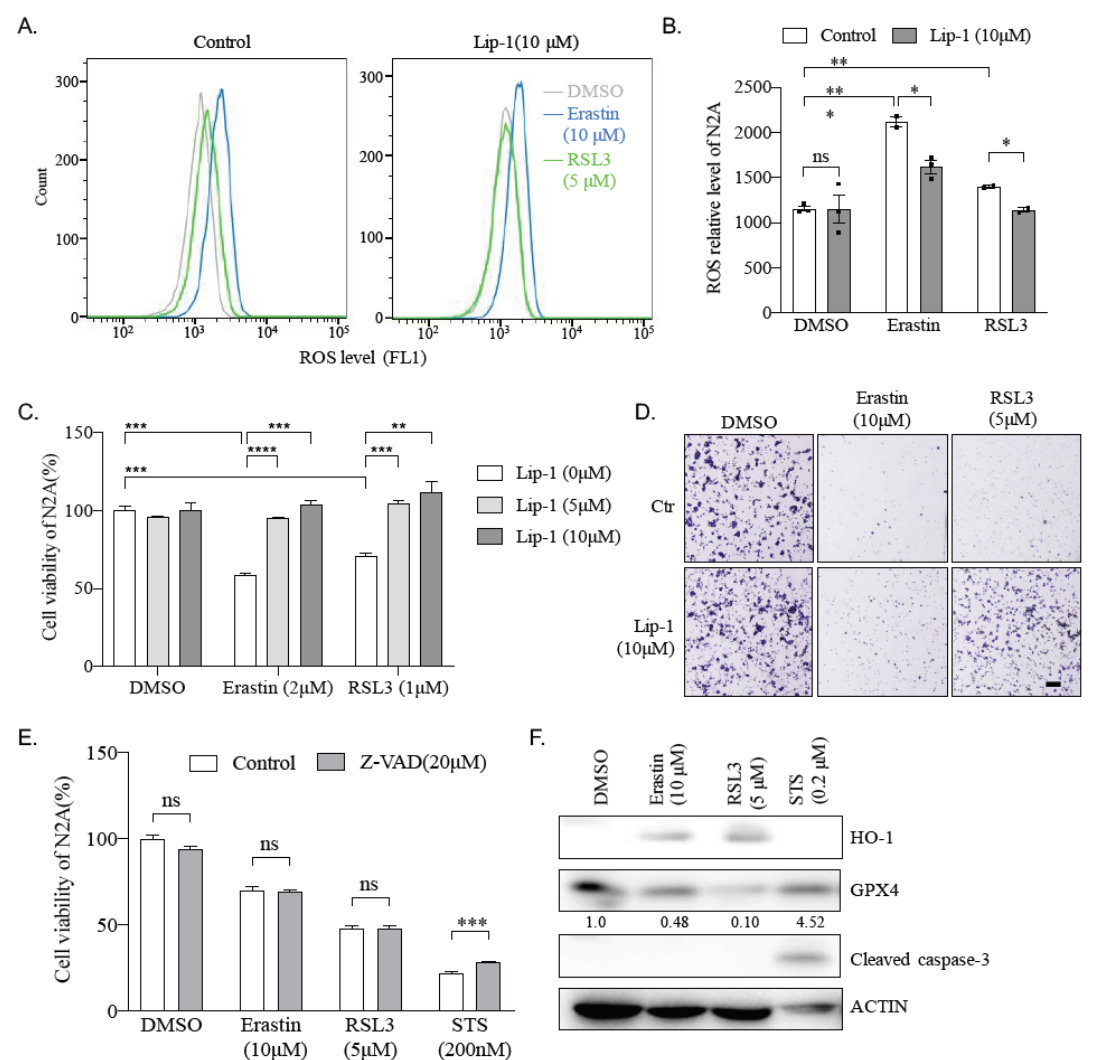
Figure 3. Erastin and RSL3 induce ferroptosis but not apoptosis and N2A cells. ( A ) Lipid ROS level in DMSO, Erastin, or RSL3 treated N2A cells for 24 h. Cells were treated with ferroptosis inhibitor liproxstatin-1 (Lip-1) for 2 h before incubation with DMSO, Erastin, or RSL3. Cells were then stained with BODIPY 581/591 C11, and lipid ROS level was detected by FACS. ( B ) Quantification of lipid ROS level in N2A cell from ( A ). Data was obtained from three independent experiments. *: p < 0.05; **: p < 0.01; ns: not significant. ( C ) Viability of N2A cells was measured after treating with ferroptosis inhibitor Lip-1 and indicated drugs for 24 h. Data were obtained from three independent experiments. **: p < 0.01; ***: p < 0.001; ****: p < 0.0001. ( D ) N2A cells were treated with DMSO, 10 µ M Erastin, 5 µ M RSL3 or a combination with 10 µ M Lip-1, stained with crystal violet, and bright-field images were taken. Scale bar = 500 µ m. ( E ) The viability of N2A cells was measured after treating with DMSO, 2 µ M Erastin, 1 µ M RSL3, or 200 nM apoptosis inducer staurosporine (STS), or combination with 20 µ M apoptosis inhibitor Z-VAD-FMK (Z-VAD) for 24 h. ***: p < 0.001; ns: not significant. ( F ) N2A cells were treated with DMSO, 10 µ M Erastin, 5 µ M RSL3, or 200 nM STS for 24 h, and protein extraction was prepared for western blotting analysis with antibodies against HO-1, GPX4, cleaved caspase-3, and β -actin. Quantified relative expression of GPX4 to β -actin by Image J. Images represent three independent